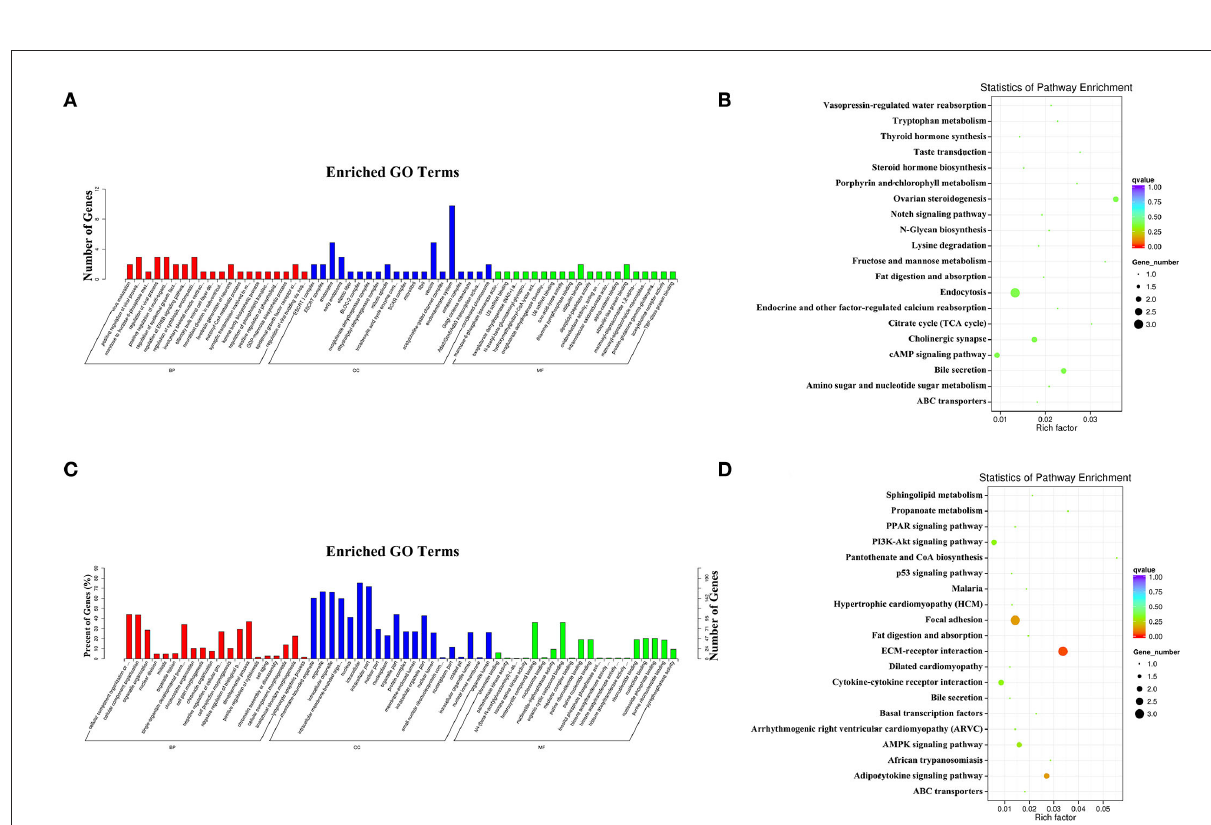
FIGURE5 The most enriched gene ontology (GO) terms (A) and Kyoto Encyclopedia of Genes and Genomes (KEGG) pathways (B) of the target genes of the DE miRNAs identified in the EL vs. PP comparison. The most enriched GO terms (C) and KEGG pathways (D) of the parental genes of the DE circRNAs identified in the EL vs. PP